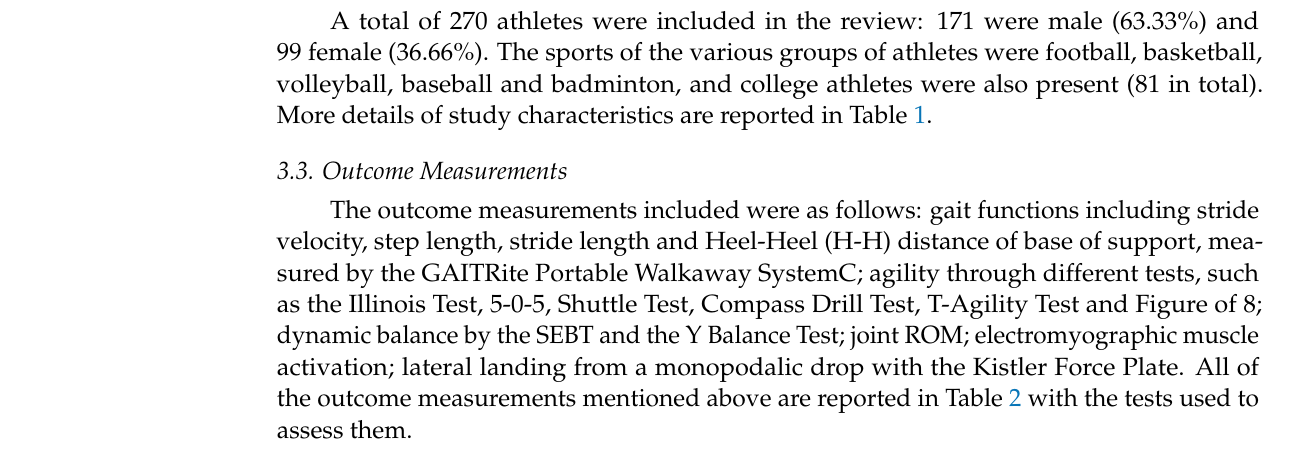
Table 2. Outcome